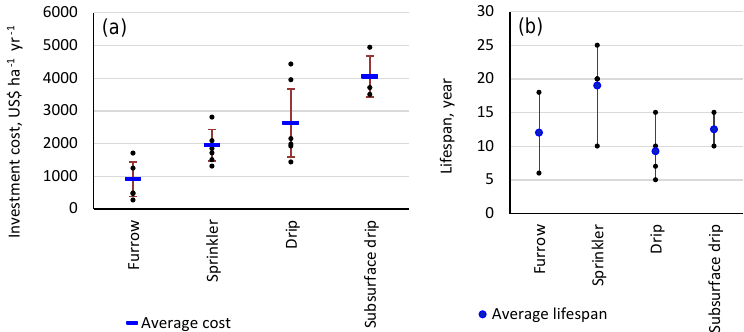
Figure 2. Annual investment cost and lifespan for irrigation